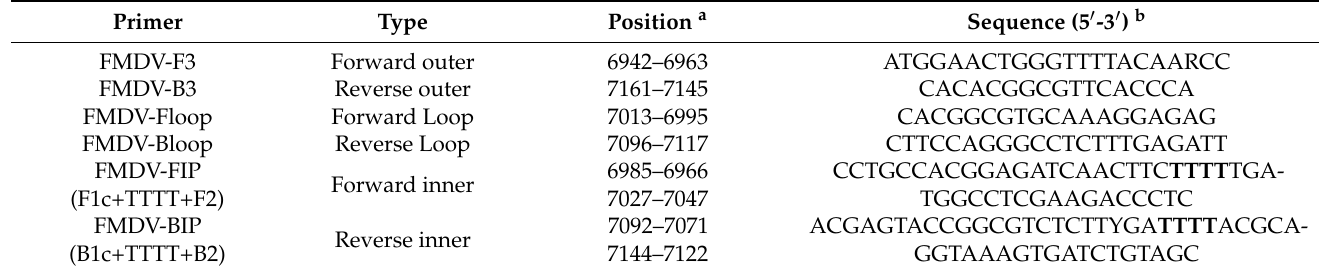
Table 2. The primer sequences for the visual RT-LAMP for pan-serotypic FMDV detection.